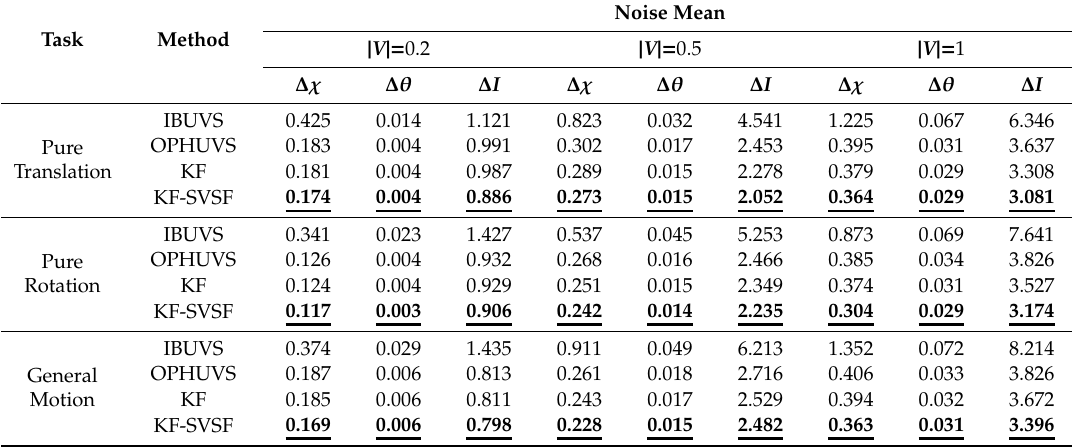
Table 2. Steady-state error of di ff erent strategies in the static positioning test. ∆ χ is in millimeters, ∆ θ is in degrees and ∆ I is in pixels. IBUVS: image-based uncalibrated visual servo. OPHUVS: original